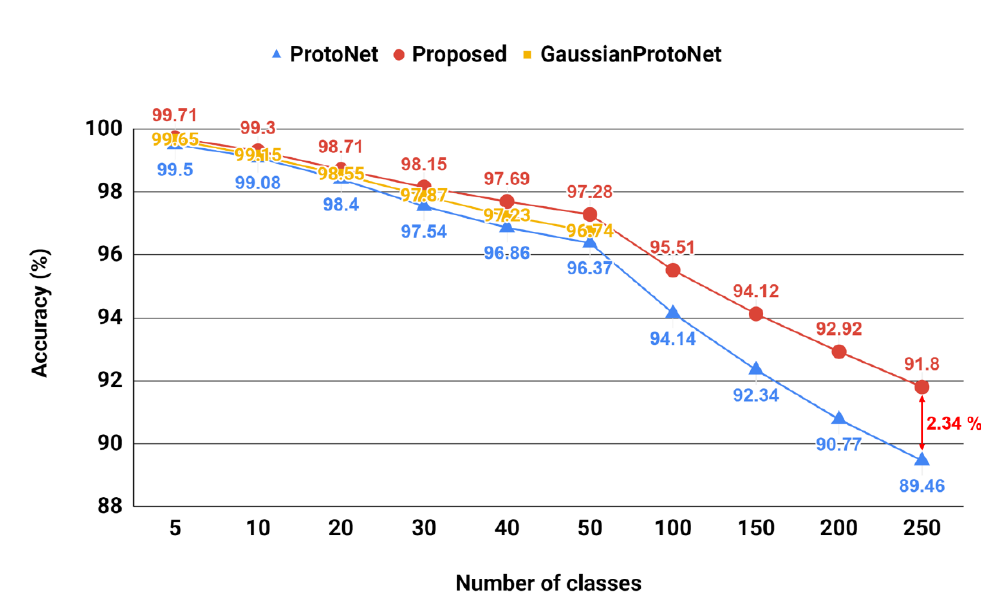
Figure 4. Change of Classification accuracy on Omniglot data depending on the number of ways (in the case of the Gaussian prototypical network, experiments were possible up to 50 ways with the provided code.).